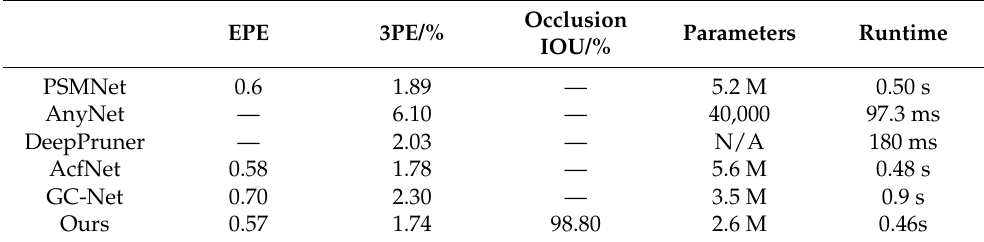
Figure 15. The left and right stereo images of the natural scene in the KITTI dataset. Table 3. Quantitative evaluation on the KITTI 2012